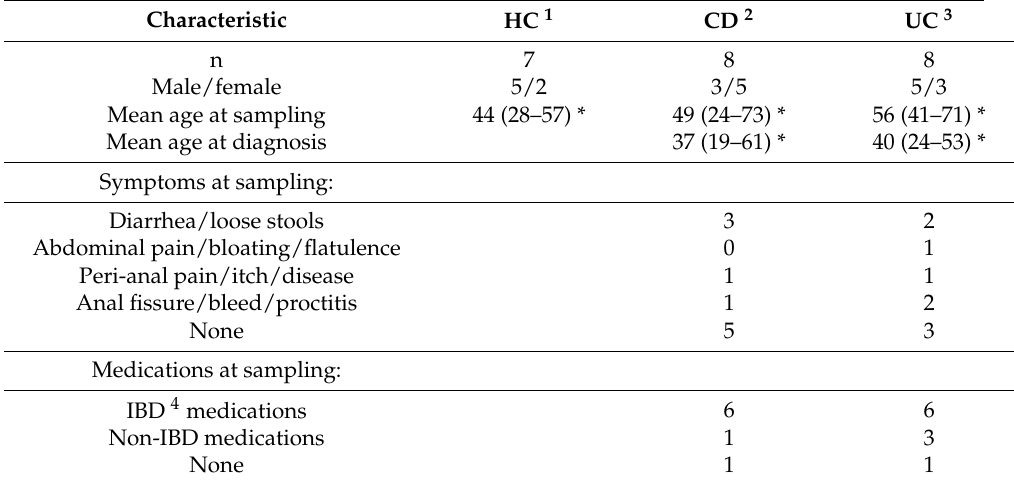
Table 1. Patient characteristics. Clinical characteristics and demographics of St Mark’s Hospital blood donors and healthy volunteers